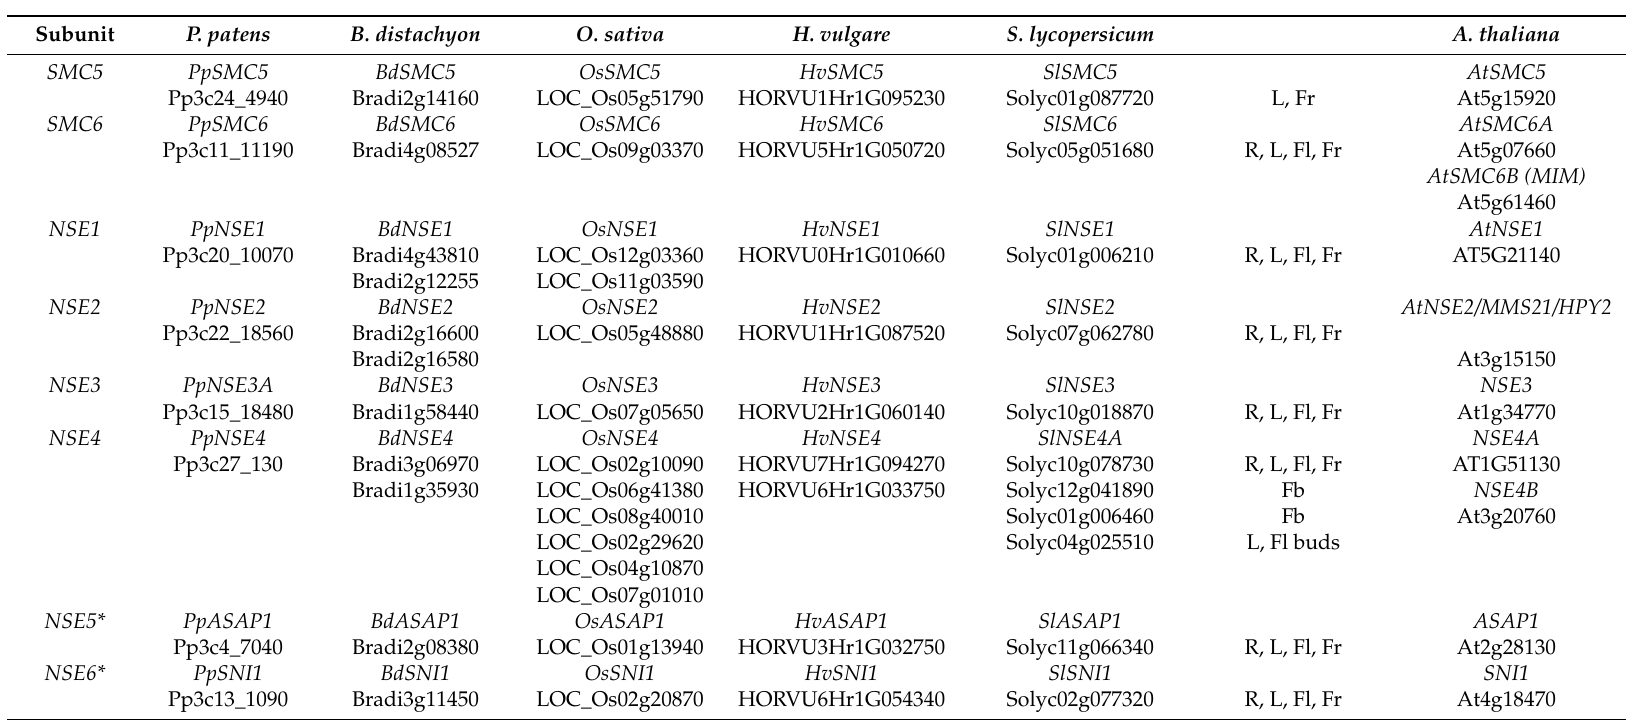
Table 2. Overview of SMC5/6 complex subunits in plants. The species are represented by spreading earthmoss ( Physcomitrella patens ), Brachypodium distachyon , Oryza sativa (rice) and Hordeum vulgare (barley), Solanum lycopersicum (tomato) and Arabidopsis thaliana (Arabidopsis). The number of gene identifiers indicates the number of copies per genome. * Functional (not protein sequence-based) homologs. Letters next to S. lycopersicum genes indicate transcript [94] in roots (R), leaves (L), flower buds (Fb), open flowers (Fl) and fruits (Fr). Transcriptional data for Arabidopsis are provided in Figure 2A. Genes for P. patens , B. distachyon , O. sativa and H. vulgare were identified by BLAST searches in Phytozome, for tomato in the Sol Genomics Network database (https://solgenomics.net/) and for Arabidopsis in TAIR